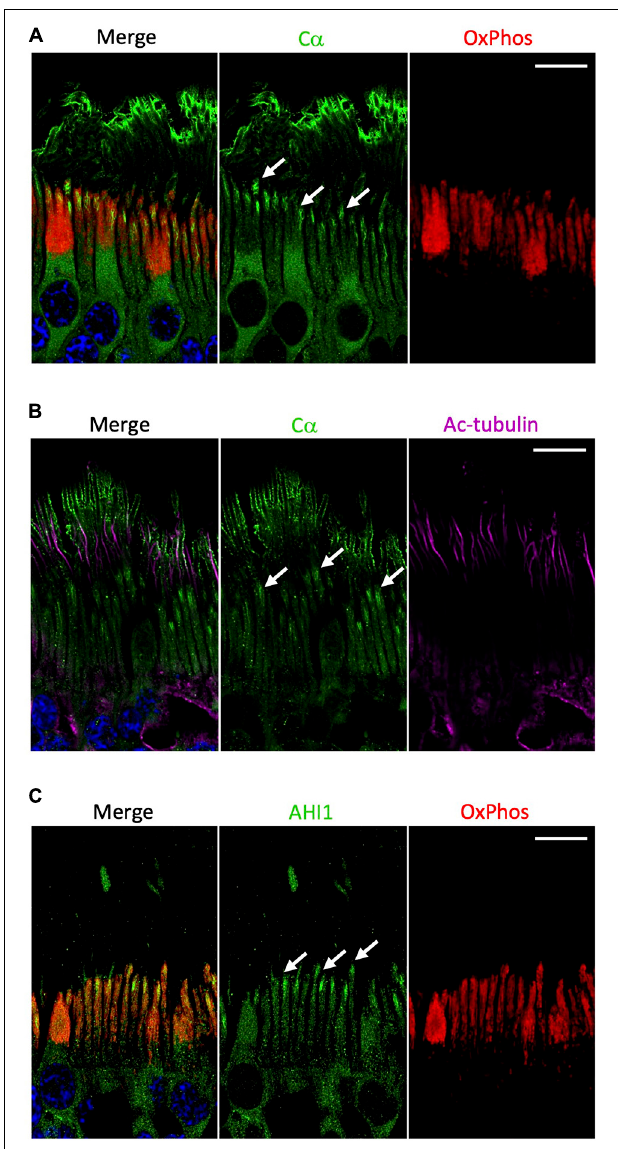
FIGURE 6 | C α is not localized with mitochondria but is localized at the base of the connecting cilium. (A) In photoreceptors, C α (green) was distinctly separate from OxPhos (red)-labeled mitochondria. C α signal was strongest in the cell body, at the base of the connecting cilium, and on the outer segment plasma membrane. OxPhos signal was enriched in the mitochondria-containing ellipsoid of the photoreceptor inner segment. (B) C α (green) and acetylated tubulin (purple) did not co-localize in photoreceptor cells, but instead showed stacked localization with acetylated tubulin in the axoneme above C α at the base of the connecting cilium. (C) Similar to C α , AHI1 (green) was localized at the base of the connecting cilium in the region connecting the inner and outer segment. (A–C) Arrows indicate localization at the base of the connecting cilium. Nuclei in blue, scale bar = 10 µ